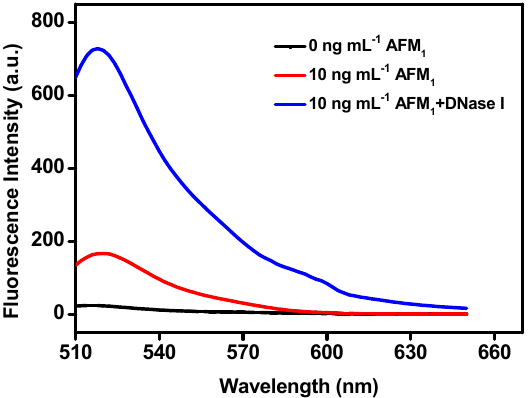
Figure 2. Fluorescence emission spectra of the aptasensor in the absence (0) of AFM 1 and in the presence of 10 ng mL − 1 AFM 1 or 10 ng mL − 1 AFM 1 and 200 U DNase I. The excitation wavelength ( λ ex ) was set at 480 nm. Conditions: 200 nM AFM 1 aptamer, 20 µ g mL − 1 graphene oxide (GO) in Tris buffer (10 mM Tris, 120 mM NaCl, 5 mM KCl, 20 mM CaCl 2 , pH 7.0).